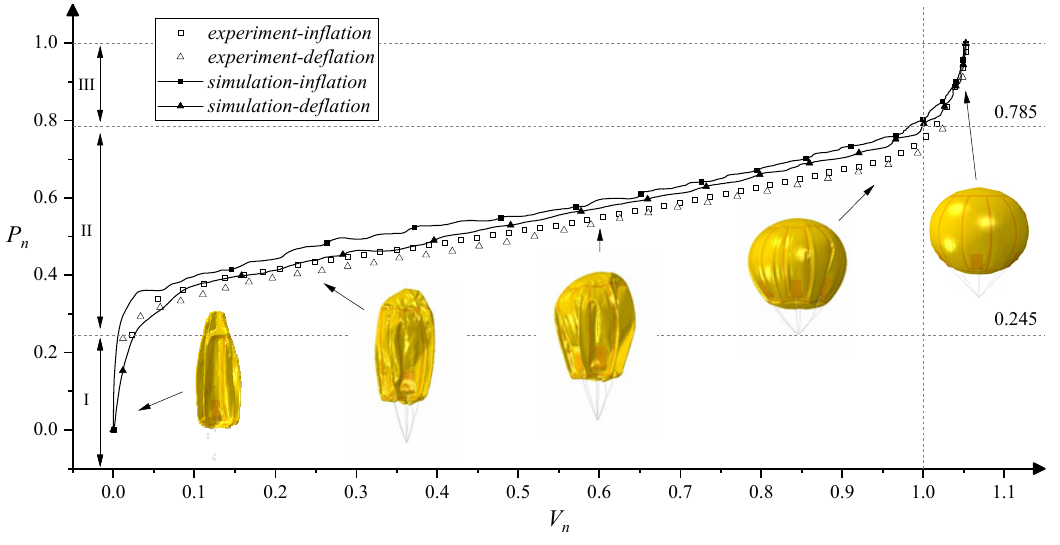
Figure 10. Relation of dimensionless pressure and inflation ratio of the 1 m airbag in the experiment and simulation.